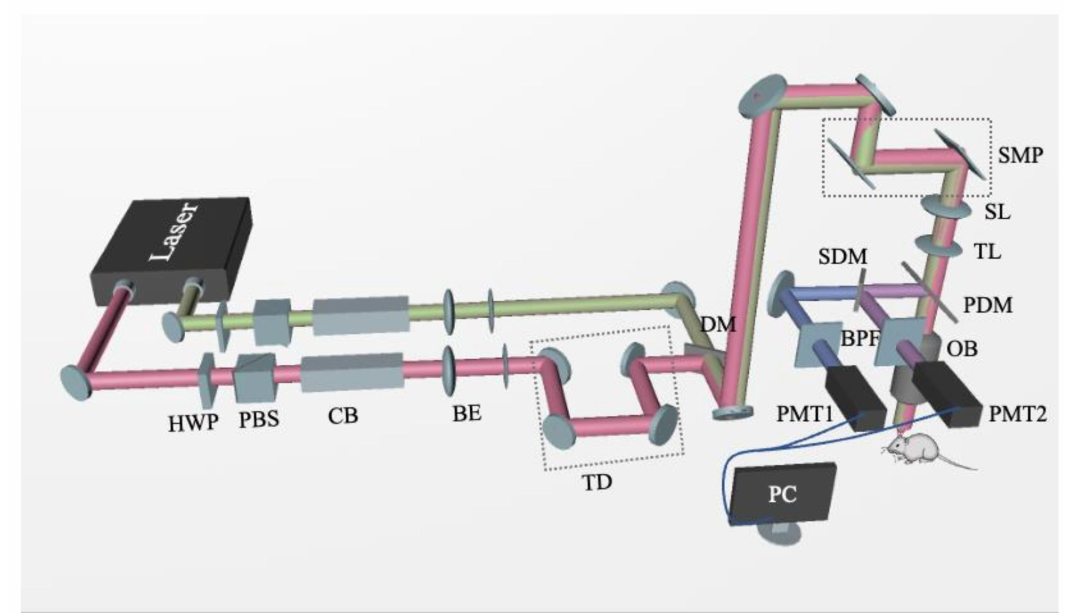
Figure 2. Schematic diagram of two-photon excitation fluorescence/coherent anti-Stokes Raman scattering (TPEF/CARS) system: Laser, Ti:Sapphire dual-output solid-state laser; HWP, half-wave plate; PBS, polarization beam splitter; CB, chirped block; BE, beam expander; TD, time delay; DM, dichroic mirror; SMP, scanning mirror pair; SL, scanning lens; TL, tube lens; PDM, primary dichroic mirror; OB, objective lens; SDM, secondary dichroic mirror; BPF, bandpass filter; PMT, photomultiplier